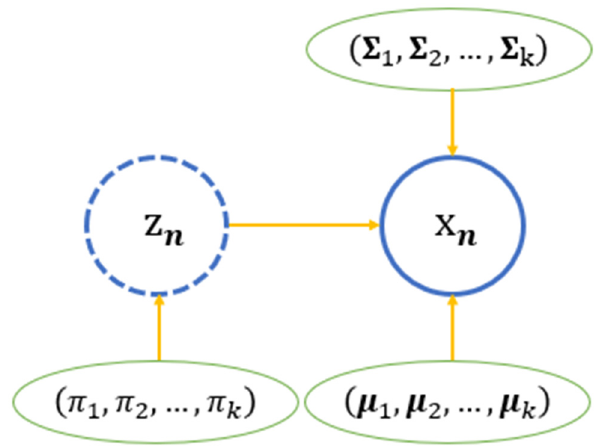
Figure 1. Graphical representation of a set of data points.